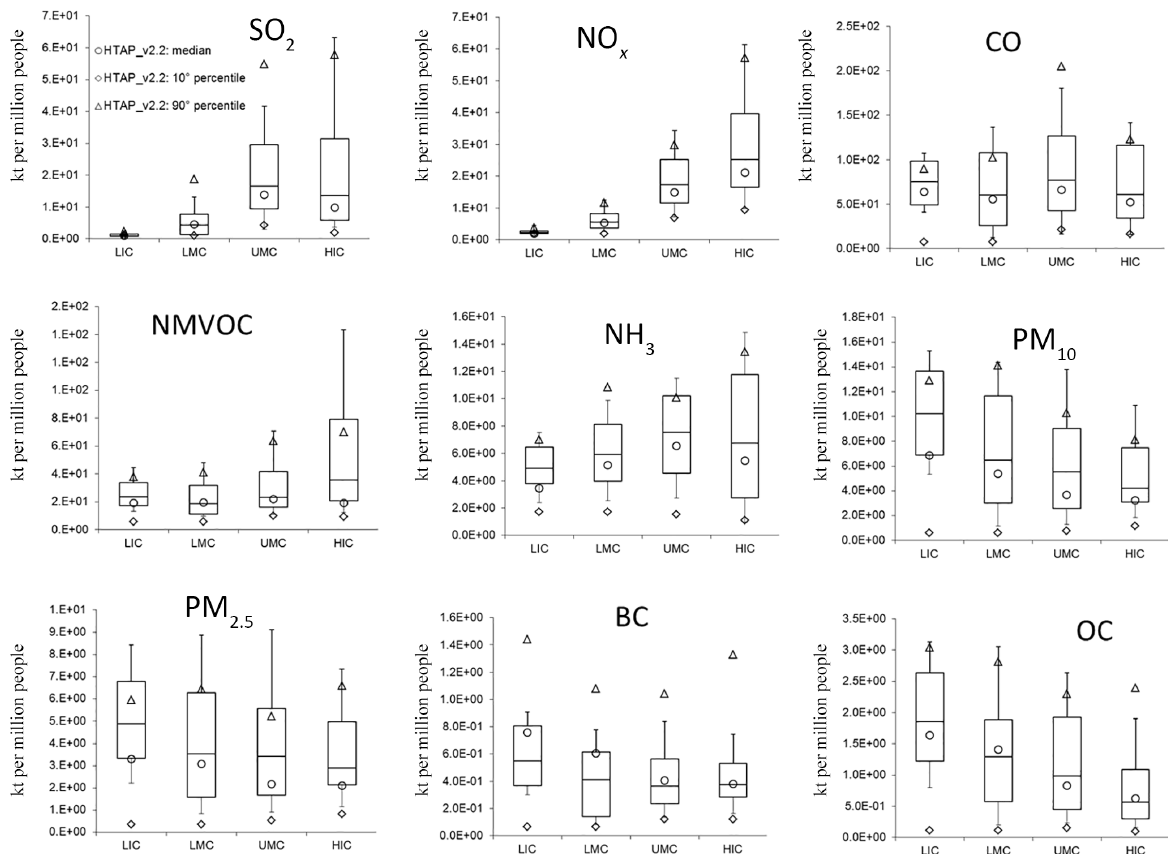
Figure 8. Per capita air pollutant emissions in 2010 (for comparability with the HTAP v2.2 inventory) per substance and group of countries are represented as box plots (10th, 25th, 50th, 75th, and 90th percentile): low income (LIC), low–middle income (LMC), upper–middle income (UMC), and high income (HIC). The comparison with the HTAP v2.2 estimates (circle is the median, diamond is the 10th percentile, and triangle is the 90th percentile; refer to Janssens-Maenhout et al., 2015) is also